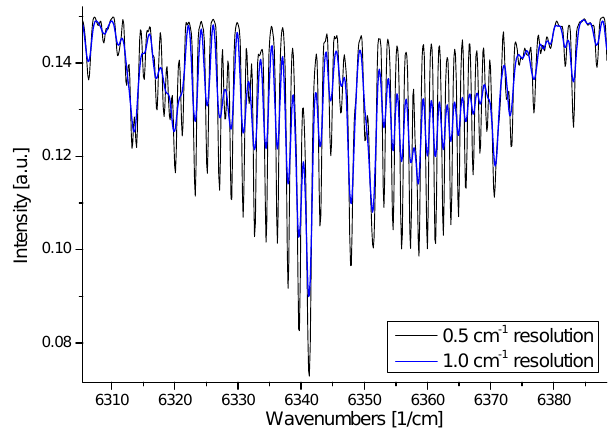
Fig. 4. A section of the CO 2 retrieval window with 0.5 and 1cm − 1 resolution. A Norton-Beer apodization function was applied to the interferogram to suppress sidelobes next to each spectral line, which is an artifact in low-resolution FTIR